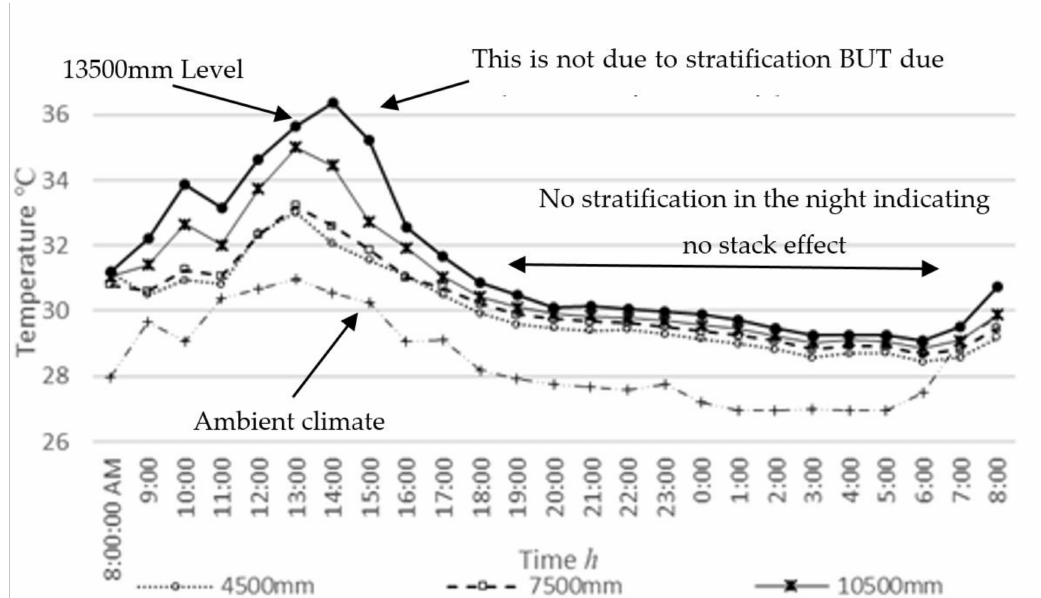
Figure 11. Vertical air temperature diversity in the atrium with its height up to 36.5 ◦ C from 29 ◦ C and indoor overheating condition well above ambient in both day and